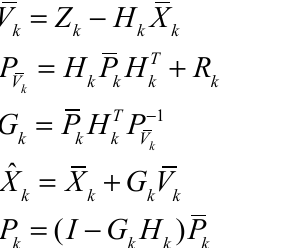
Figure 4. Force balance in the air in the stationary condition: (a) Horizontal force conditions, (b) Vertical force condition